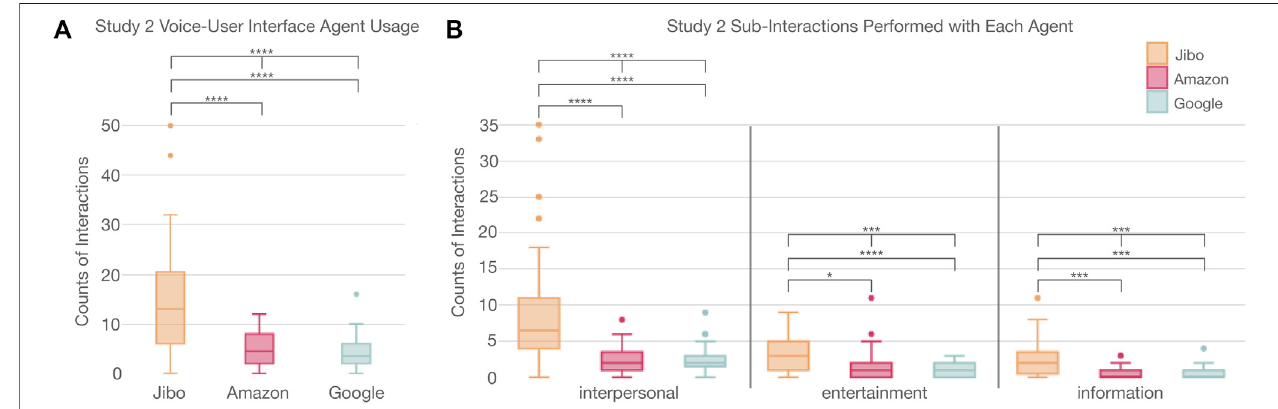
FIGURE 7 | (A) Signi fi cant trend in usage of voice agents between participants showing Jibo had a signi fi cant higher usage than Amazon or Google Home. (B) Distribution of the interactions completed with various agents showing that participants engaged with agents different for interpersonal, entertainment, and information based